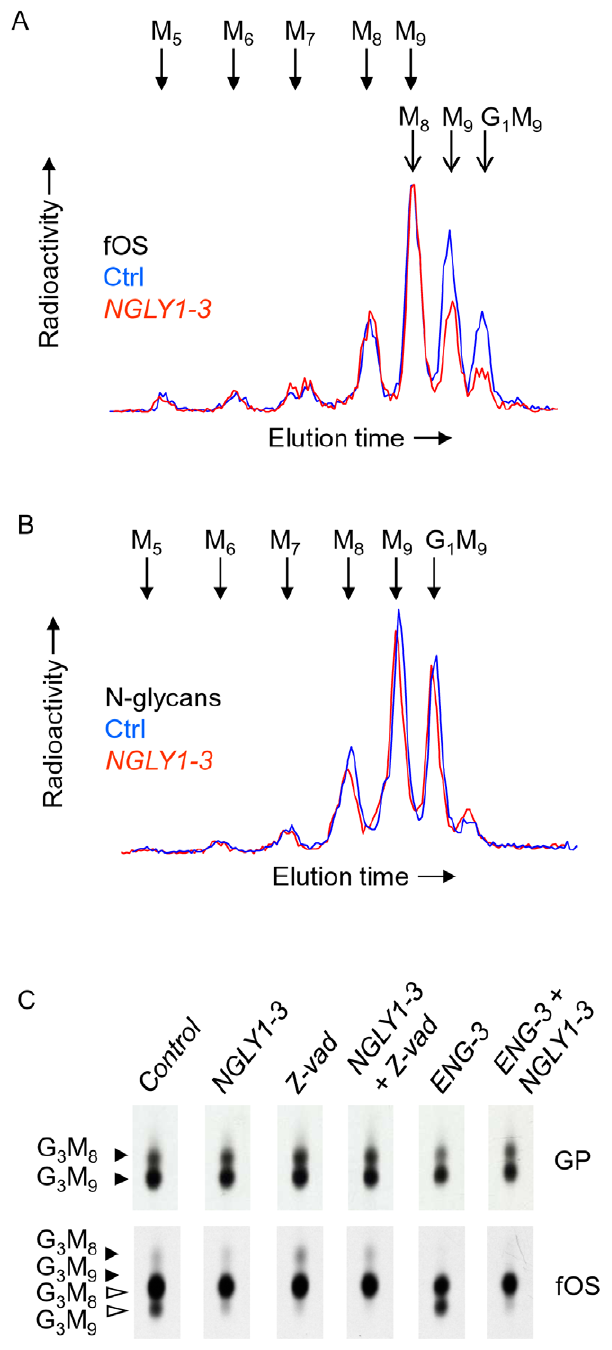
Figure 5. Examination of fOS, and N-glycans after NGLY1-3 or Z-vad mediated reduction of Ngly1p activity in control and castanospermine-treated cells. A. HepG2 cells were transfected with 25 pmoles of control siRNA (Ctrl), or 25 pmoles of NGLY1-3 . Three days after transfection, cells were pulse-radiolabeled with [2- 3 H]man- nose for 30 min and cellular EndoH-released [2- 3 H] N -glycans ( N -glycans) and [2- 3 H]fOS (fOS) were prepared and analysed by HPLC. Whereas the whole fOS fractions were analysed, only 25% of the N -glycan fractions were examined by HPLC. The elution positions of standard oligosac- charides are indicated above the HPLC profiles and the abbreviations used are defined in the legend for Fig 2. B. HepG2 cells were transfected with 50 pmoles of control siRNA (Ctrl), or 25 pmoles each of NGLY1-3 and 25 pmoles of control siRNA (NGLY), or 25 pmoles each of ENG-3 and 25 pmoles of control siRNA (ENG), or 25 pmoles each of NGLY1-3